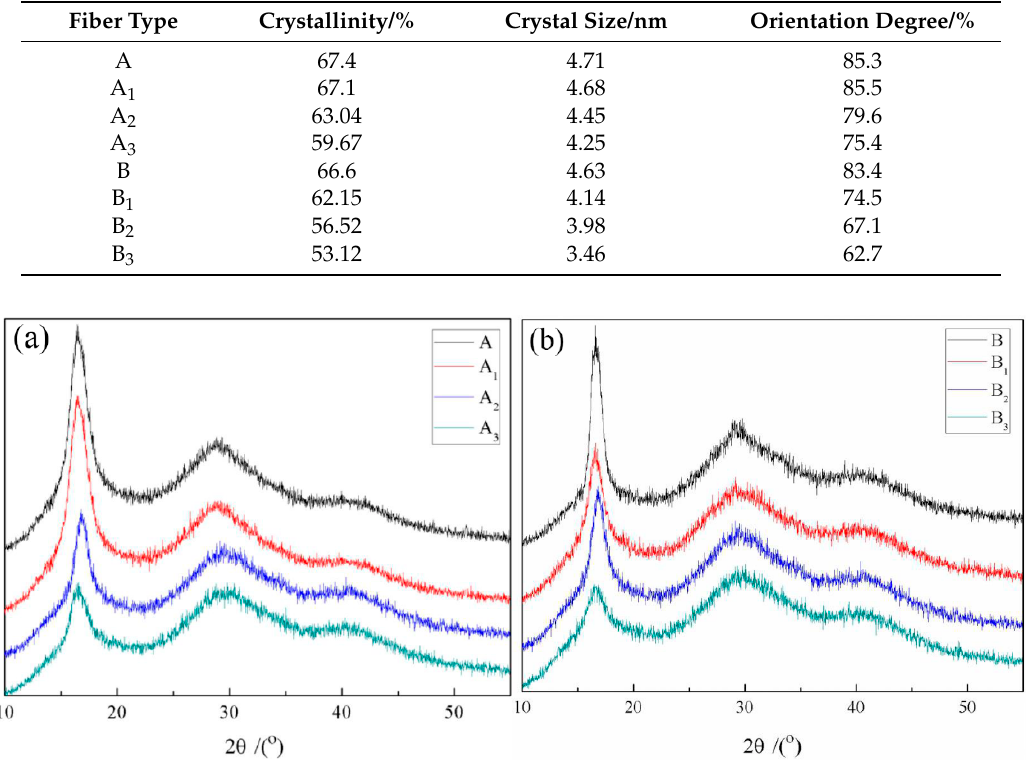
Table 4. XRD data of different diameter PAN fibers after modification.